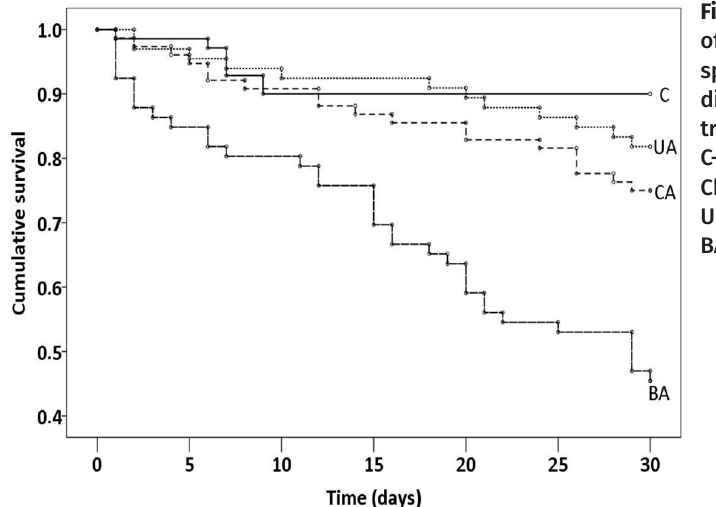
Figure 2. Survival curve of Callinectes ornatus specimens subjected to different